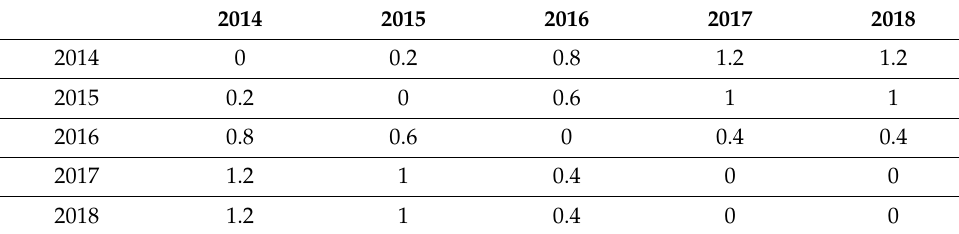
Table 4. Matrix of distances to build up the fuzzy number “Belgian SER within